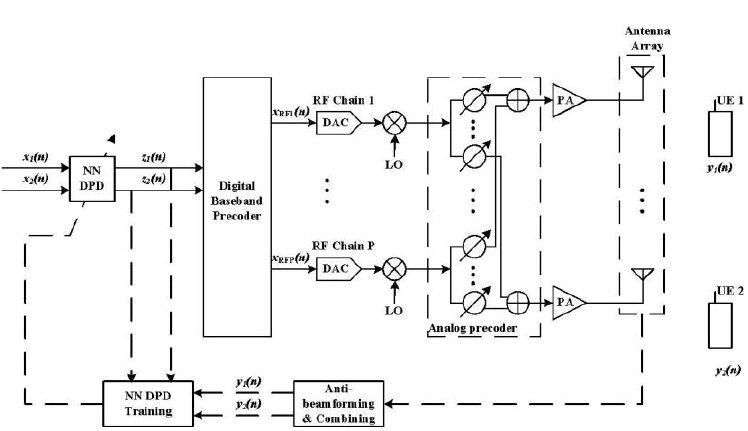
Figure 6. Architecture 1 of RVTDNN2L DPD for MU FC HBF MIMO transmitter with one NN.